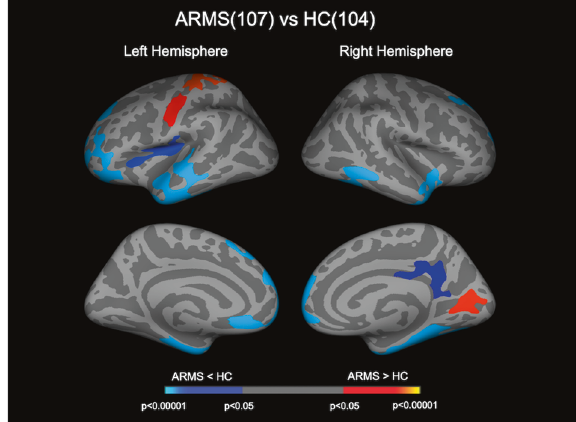
Fig. 2 Cluster showing difference in CT between ARMS-R and ARMS-NR. Cortical statistical maps displaying reduced CT in the ARMS-NR group compared with the ARMS-R group. The horizontal bar shows p values corrected for multiple comparisons. ARMS at-risk mental state, ARMS-NR non-resilient ARMS individuals, ARMS-R resilient ARMS individuals, CT cortical